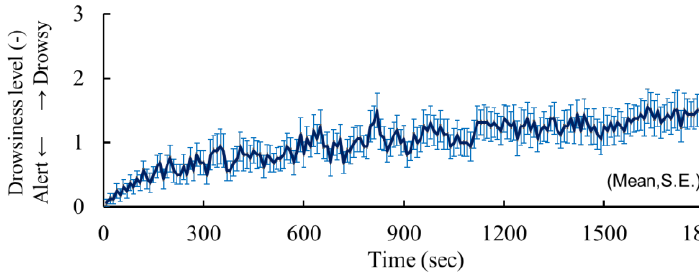
Figure 5. Changes in the mean of the drowsiness level, N = 16, Error bars represent SEM [20].